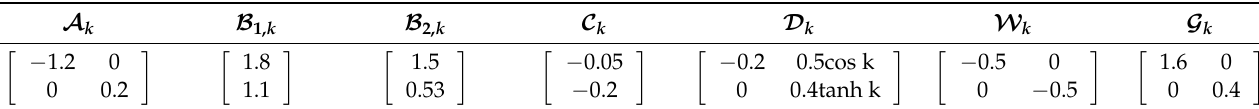
Table 1. Coefficients of dynamic system